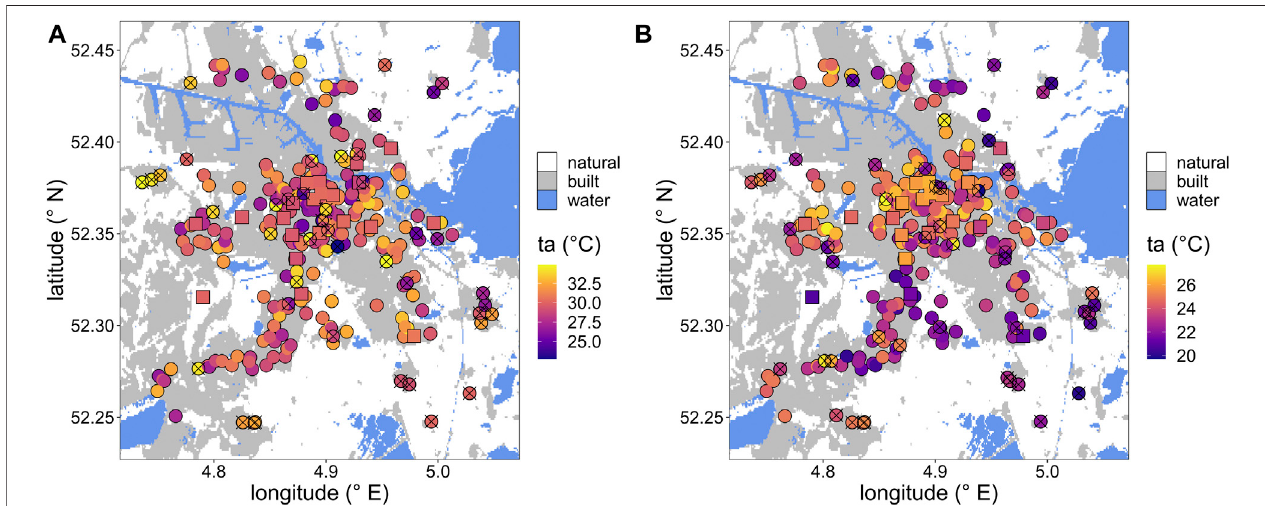
FIGURE 6 | Air-temperature ( ta ) distribution in Amsterdam for (A) June 29, 2019 13:00 UTC and (B) June 30, 2019 01:00 UTC as measured by CWS (circles) and PRWS (squares). CWS data are displayed at QC level m4, crosses mark values that were removed in QC level m5 (radius: 3000 m, minimum number of buddies: 5, alpha: 0.1). Note the different colour scales in the two subplots. Underlying landcover derived from the LCZ map (natural: LCZ A-F, built: LCZ 1-10, water: LCZ